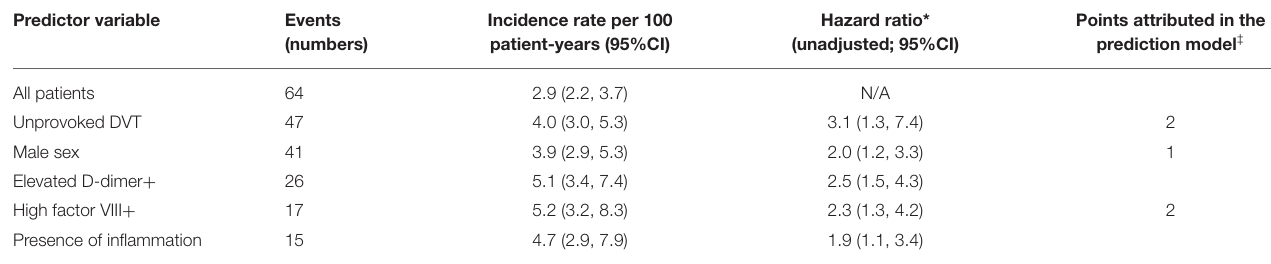
TABLE 2 | Recurrence rates and hazard ratios according to predictor variables. Predictor